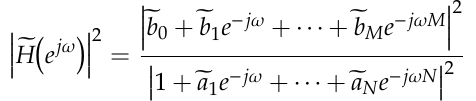
Figure 4. System model for Stiglitz ‐ McBride